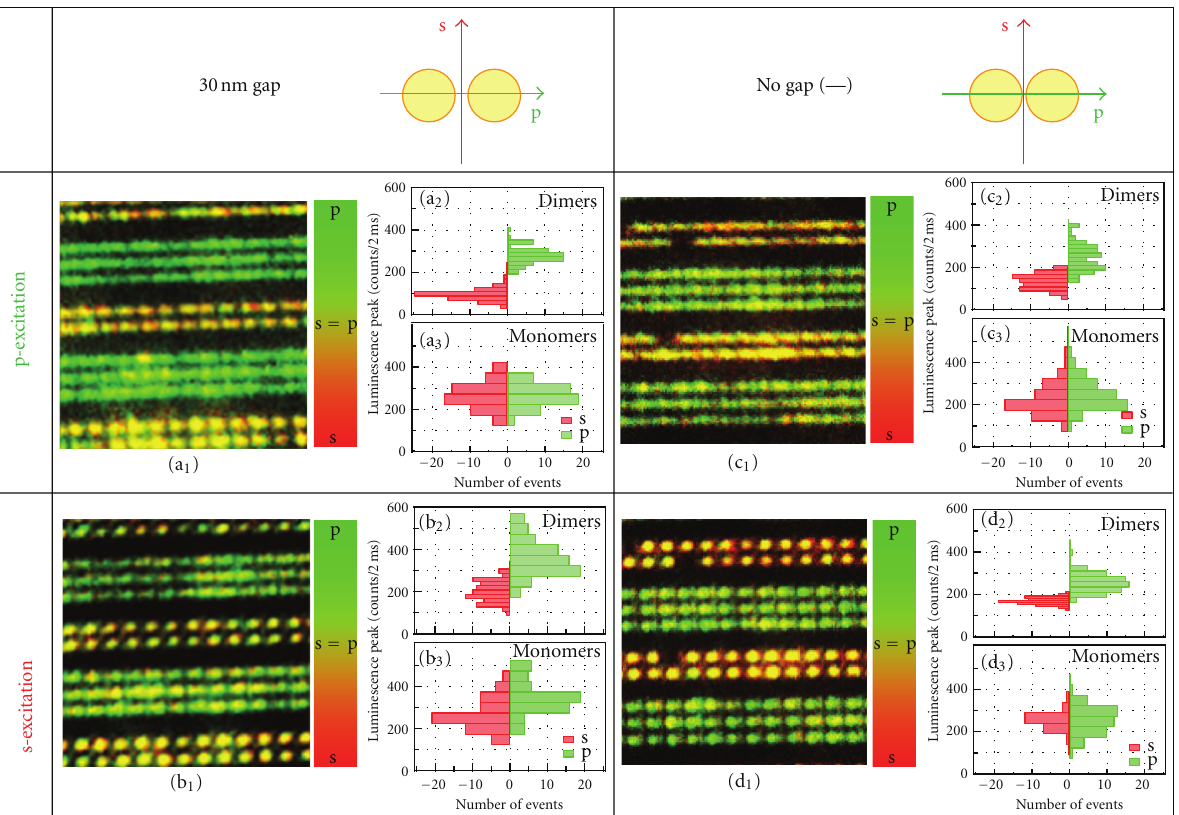
Figure 6: Luminescence measurements of single gold dimers with a gap of 30nm (a and b) and with no gap (c and d). The figures (a and c) illustrate the luminescence of the structures when illuminated with p-polarized light (i.e., parallel to the long axis of the dimers). Figures (b and d) show the same results for s-polarized excitation light (perpendicular to the dimer axis). (a 1 to d 1 ) Show luminescence images of a 10 × 10 μ m scanned area. The color scale gives the polarization state of the detected field. (a 2 to d 2 ) and (a 3 to d 3 ) Show distribution of the luminescence peak for dimers (over 60 dimers were considered for each case) and monomers (over 50 monomers were considered for each case), respectively.